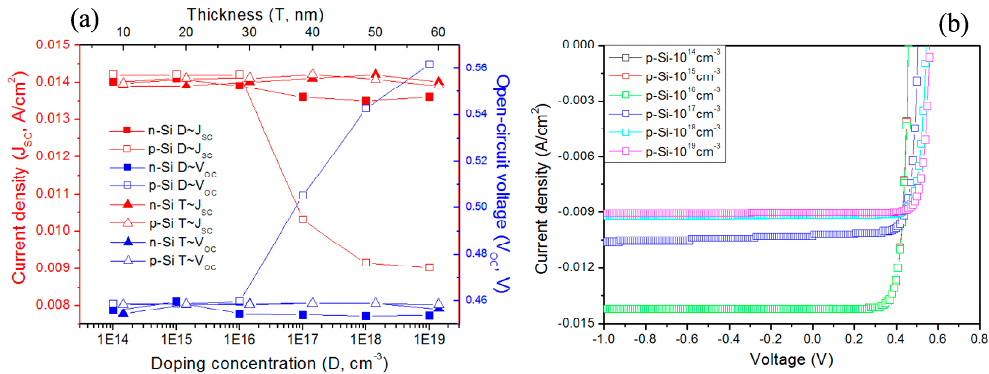
Figure 2. Simulated J SC and V OC of the p/n-Si DSL structure on 6H-SiC with different impurity concentrations and thicknesses under a visible illumination of 0.1 W/cm 2 ( a ); J-V curves of the Si-DSL/6H-SiC heterostructure with different impurity concentrations of the p-Si layer ( b ).